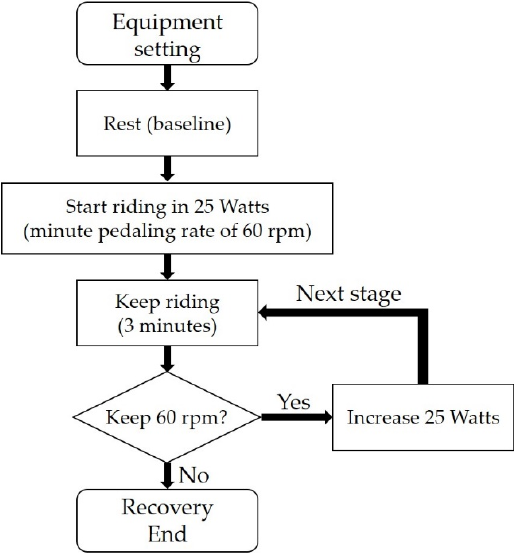
Figure 1. Incremental cycle experiment. Prior to the resting stage, the setting of the indoor trainer was fitted to the patient’s height. The physical load was increased by 25 watts. The ICG measurement was performed from rest to recovery stages.